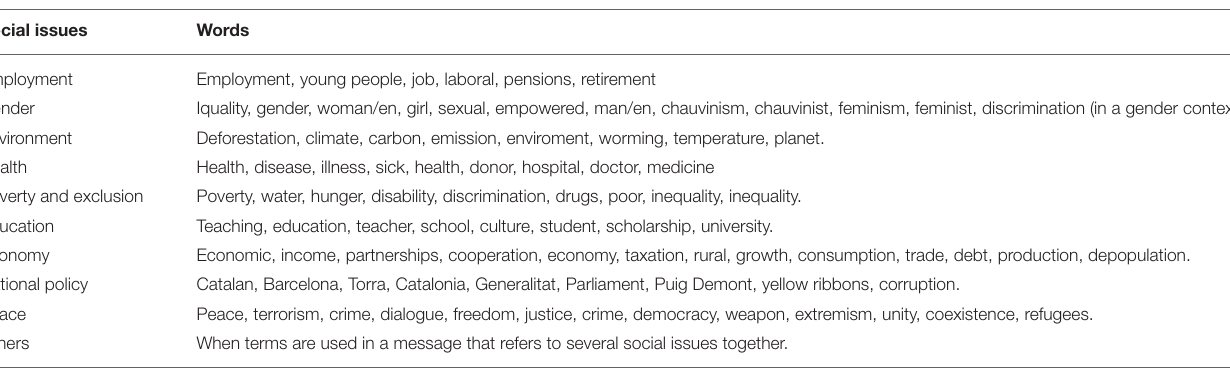
TABLE 4 | Words identifying social